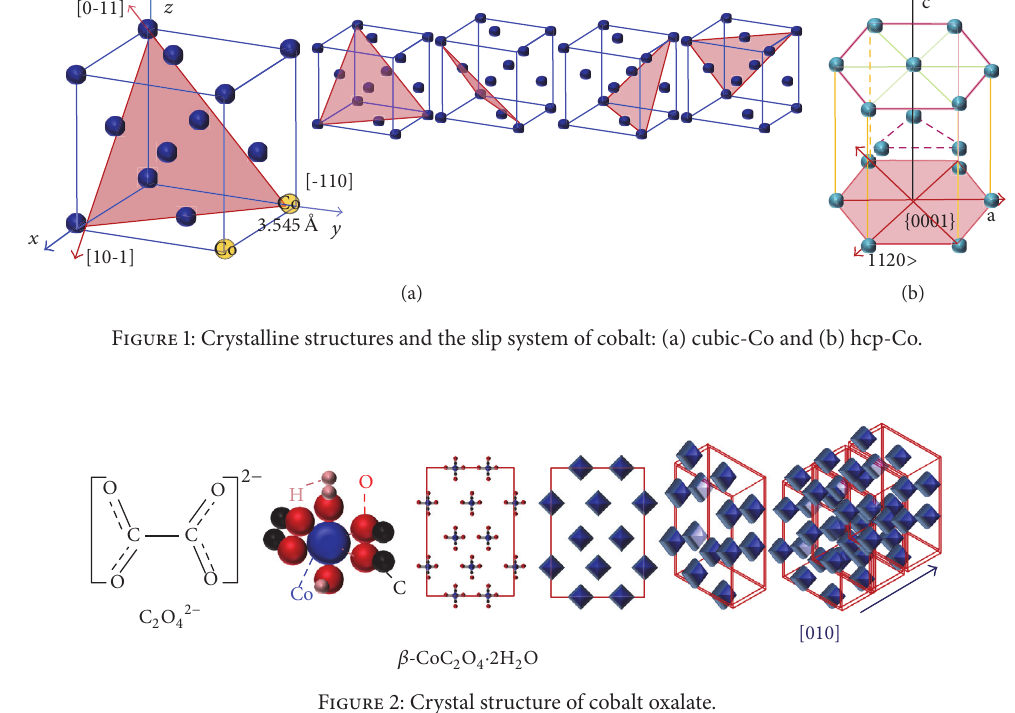
Figure 2: Crystal structure of cobalt